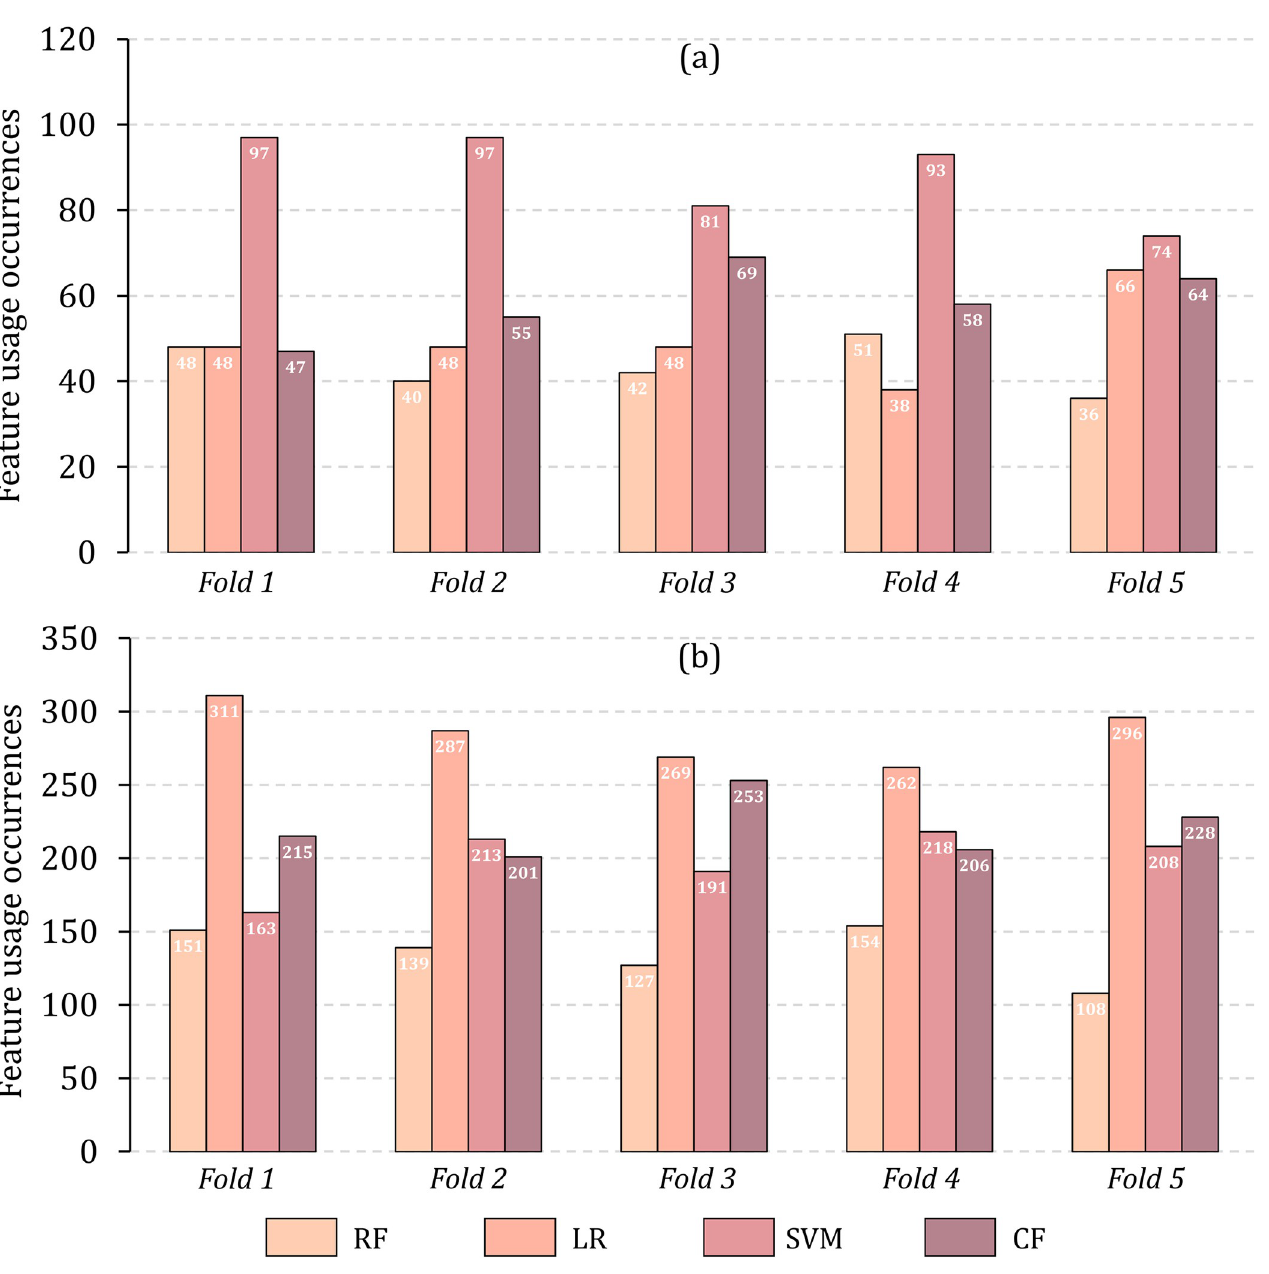
Fig 5. The usage frequencies of component methods, calculated by Apache commons-math3 library and RankLib library. (a) shows the usage frequencies of component methods on S a dataset via five-fold cross-validation; (b) shows the usage frequencies of component methods on S p ben validation.